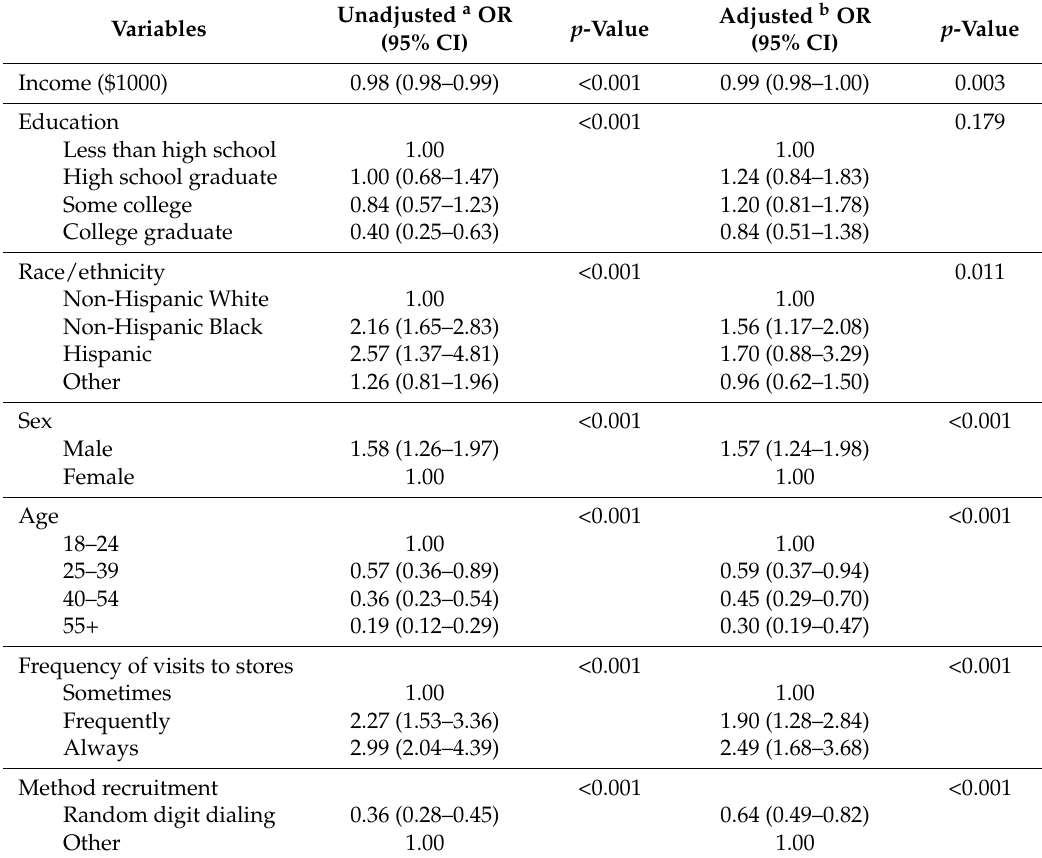
Table 2. Odds ratios (OR) and 95% confidence intervals (CI) from ordered logistic regression of POS cigarette marketing on covariates ( n =